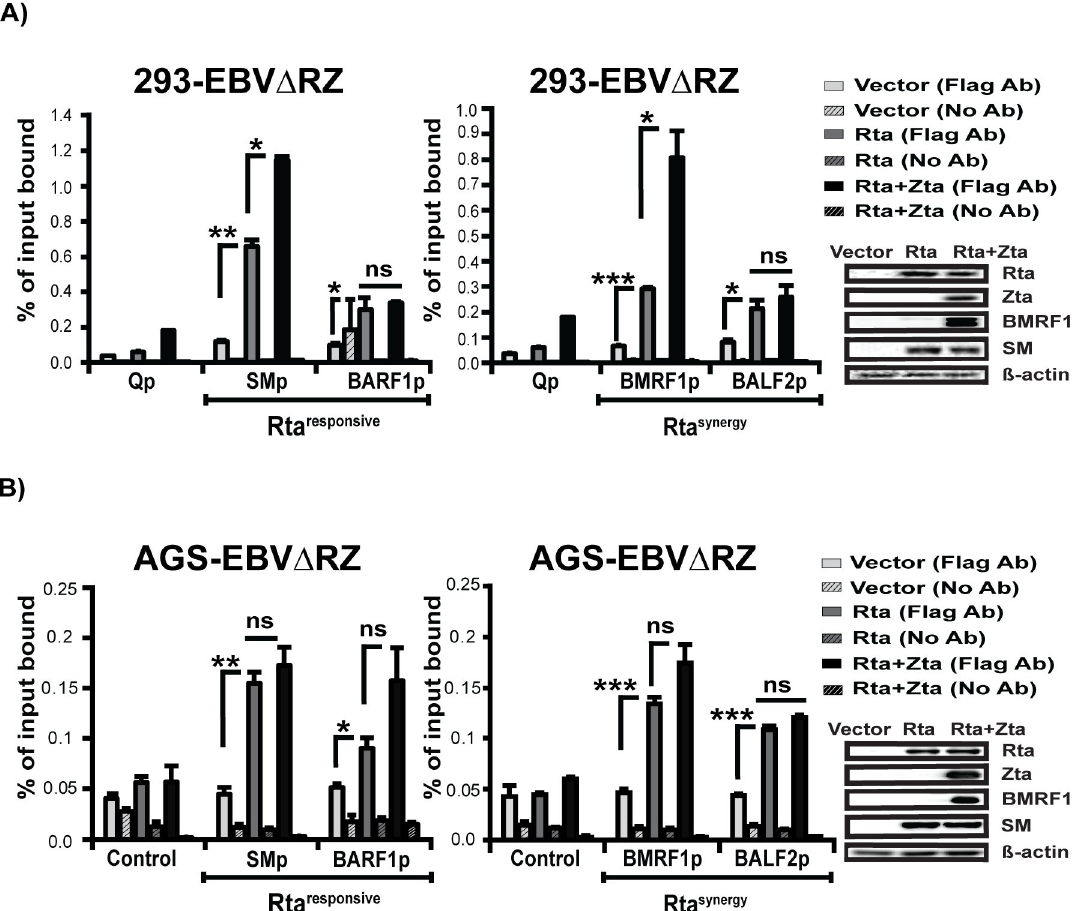
Fig 8. Zta increases Rta binding at Rta responsive and Rta synergy gene promoters. Chromatin Immunoprecipitation quantitative PCR (ChIP-qPCR) data from (A) 293-EBV Δ RZ or (B) AGS-EBV Δ RZ showing Zta association with control (Qp), Rta responsive (SMp and BARF1p) and Rta synergy (BMRF1p and BALF2p) promoters. Crosslinked-chromatin was prepared from cells trans-complemented with vector, Rta-flag (Rta) or Rta-flag and Zta (Rta+Zta) and immunoprecipitated using anti-Flag antibody (Flag Ab) or left untreated (No Ab) and quantified relative to input DNA. For each chromatin prep, western blots were performed (far right panels) to ensure early gene induction (BMRF1 and SM) and that equivalent amounts of Rta were expressed in the Rta and Zta+Rta conditions. Significant differences are indicated as follows: P � 0.05 ( � ), P � 0.01 ( �� ), P � 0.001 ( ��� ), P > 0.05